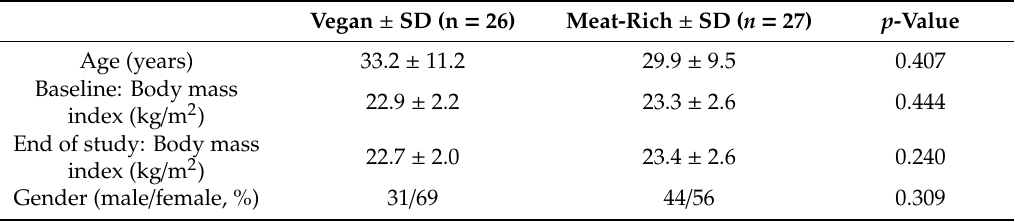
Figure 2. Flow chart depicting randomization scheme of participants into vegan (VD) and meat-rich diets (MD). Table 1. Demographic data of participants in vegan diet group and in meat-rich group (SD = Standard deviation, p -value from t -test).